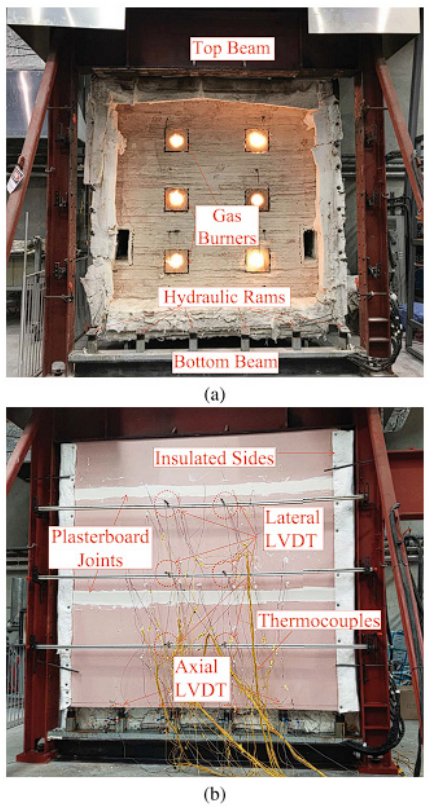
Figure 22. The full ‐ scale fire ‐ resistance ‐ test setup: ( a ) furnace, and ( b ) test panel. Figure 22. The full-scale fire-resistance-test setup: ( a ) furnace, and ( b ) test